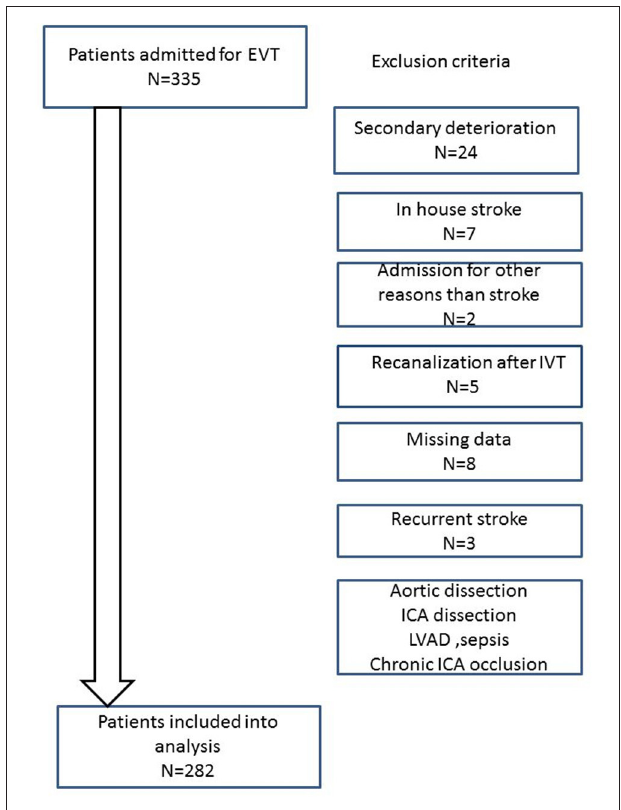
FIGURE 1 | Flowchart displaying the exclusion criteria. Patients with secondary deterioration had presented without neurological symptoms or a rapid improvement in the emergency room but had developed severe neurological deficits hours later. As we aimed to analyze the quality of our prehospital care and flow of our emergency processes, we decided to exclude these patients from further analyses because they are not representative of the “usual” workflow.